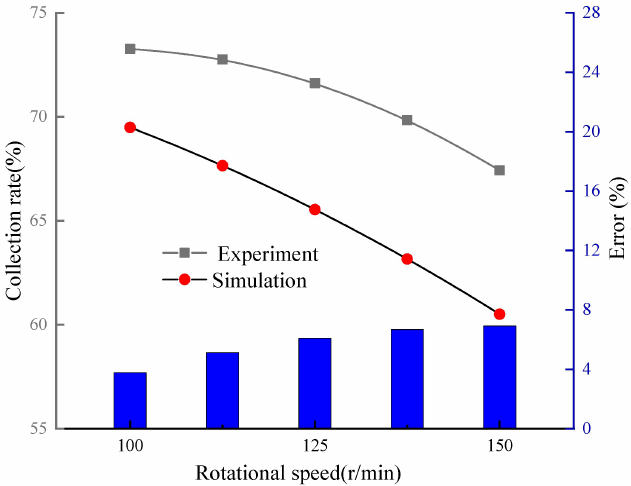
Figure 11. Relationship between gear speed and picking